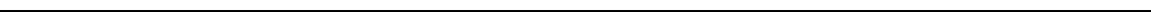
Fig. 9 CX3CL1 prevents HPMo activation by chemokines required for monocyte homing. a Role of chemokines in HPMo transmigration promoted by angiogenic factors. Human monocytes were treated with PBS or pertussis toxin (PTX) at 1 µ g/ml before applying them under fl ow to HUVECs prestimulated with TNF or TNF + VEGF-A. n = 3 experiments, data are mean ± s.d., two-way ANOVA with Holm-Sidak adjustment. b Kinetics of calcium fl ux in monocyte induced by sequential stimulations with chemokines analyzed by Fura2 QBT ratiometric assay. Black arrows indicate the time of chemokine addition. The chemokines were tested at 50 ng/ml. c Effect of blocking CX3CR1 on calcium fl ux induced by sequential stimulation of monocytes by chemokines. Monocytes were treated with either rabbit IgG or anti-CX3CR1 at 50 µ g/ml prior to sequential activation. Data were reproduced in